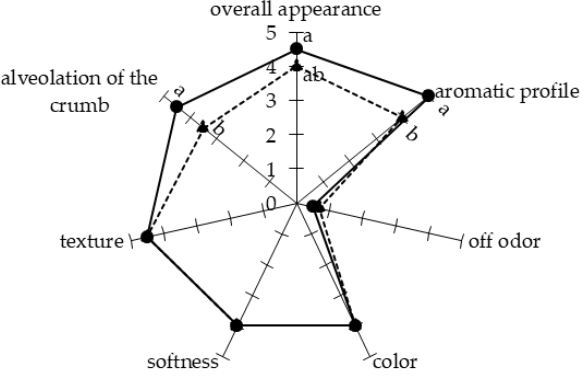
Figure 2. Sensory attributes of bread obtained by fermentation with S. cerevisiae “Lievital” (triangle, dashed line) or co-fermented with L. plantarum UFG 121 (circle, continuous line). Reported values are means of six independent replicates, and they are expressed by using a hedonic scale from 1 to 5 (1 = atypical, undesirable; 5 = typical, desired). Means with different letters are significantly different according to Tukey’s test ( p ≤ 0.05).